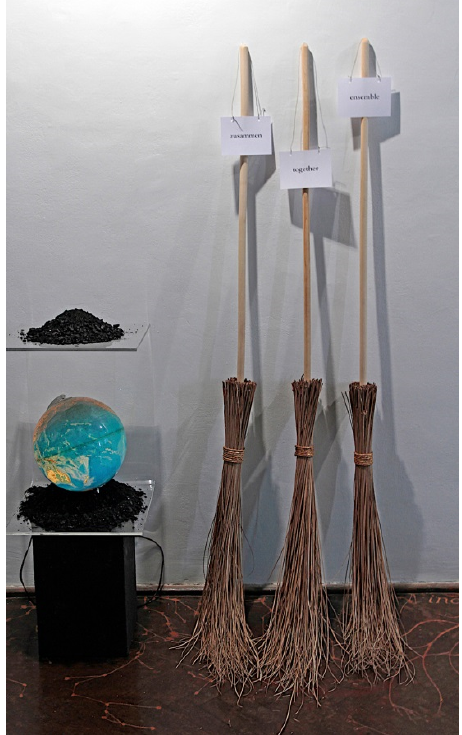
Figure 10. Leon Podsiadły, Razem [ Together ], 2019, ready made (brooms). Photograph by Andrzej Rerak. Photograph shared courtesy of Entropia Gallery and with the permission of the artist’s family.